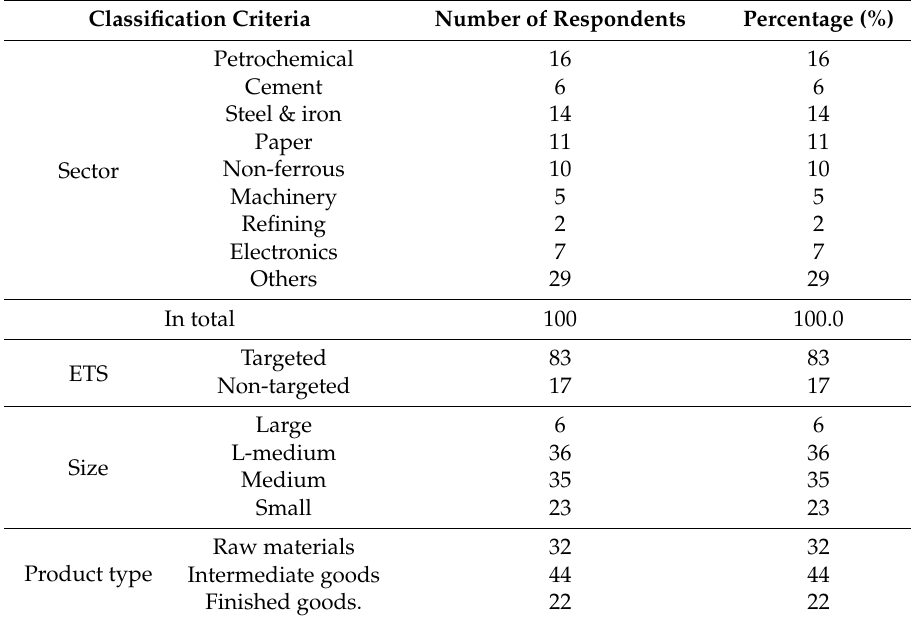
Table 5. Distribution of valid